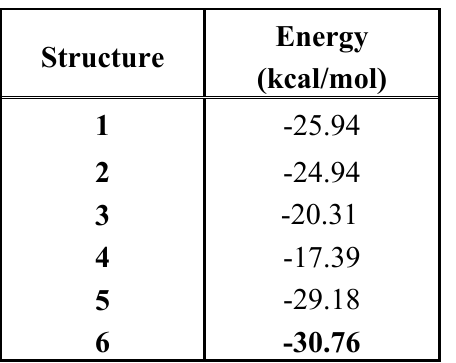
Table 1. Calculated interaction energies (kcal/mol) of the BCD- methoprene complexes.